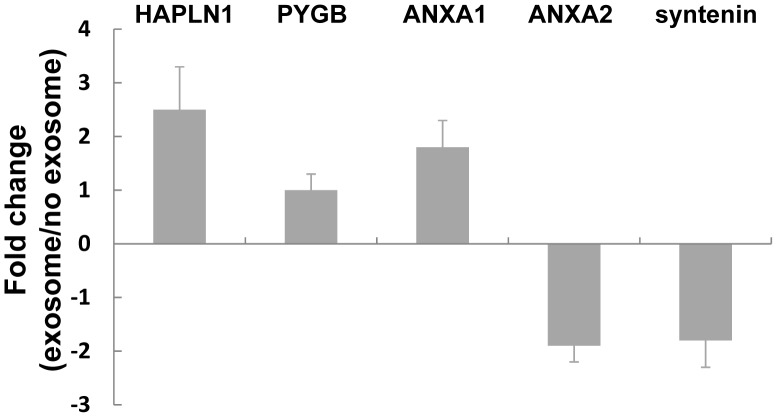
Gene expression changes of normal melanocyte after taking-up melanoma cell-derived exosomes.HEMa-LP cells were seeded in a 6-well plate. The next day, A375 exosomes were added into the plate. No exosome media was used as a control. After 5 days, total HEMa-LP cell RNA was isolated by mirVana kit and reverse transcribed to cDNA. Expression levels of mRNA were analyzed by RT-PCR. Samples were run in triplicate with at least 3 independent experiments. The bars represent normalized percentage (%) of fold change values with mean ± SD between HEMa-LP cells with exosomes and with no exosomes.